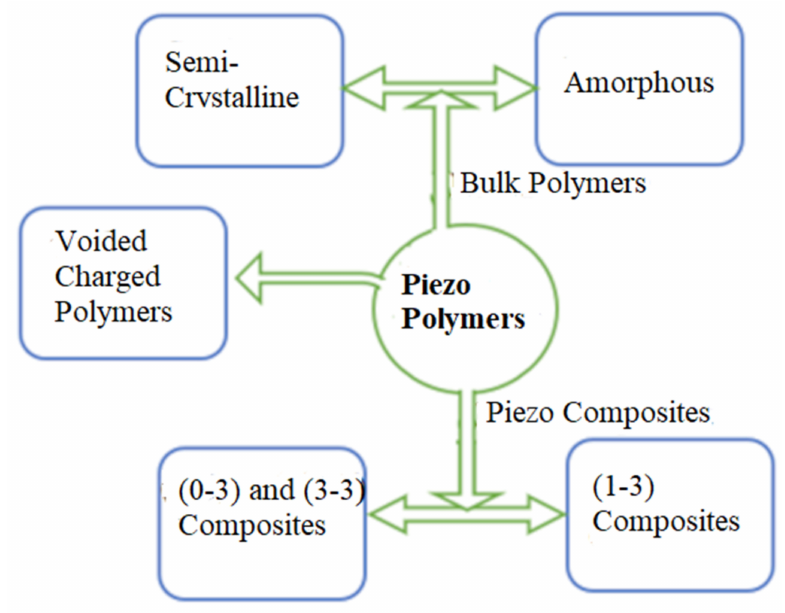
Figure 2. Schematic diagrams of piezoelectric polymer types. Piezoelectric Thin